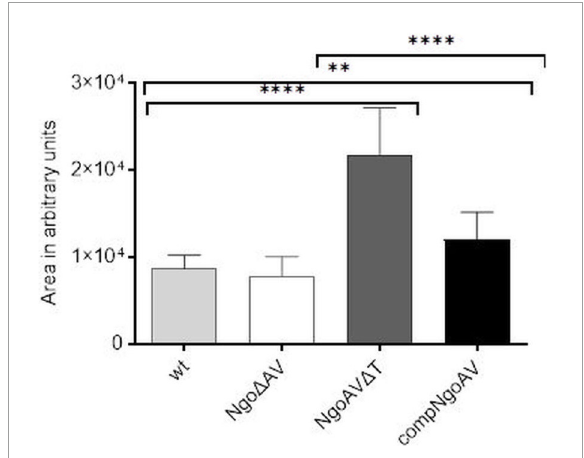
FIGURE5 Sizes of individual N. gonorrhoeae cells from different variants within M.NgoAV locus, forming biofilm, seen under SEM and measured with ImageJ (in arbitrary units). Asterisks represent statistically significant differences in comparison to the wt strain and between NgoAV (cid:49) T and compNgoAV ( p < 0.05). Data are means of area of at least twenty cells from three independent experiments ( ±